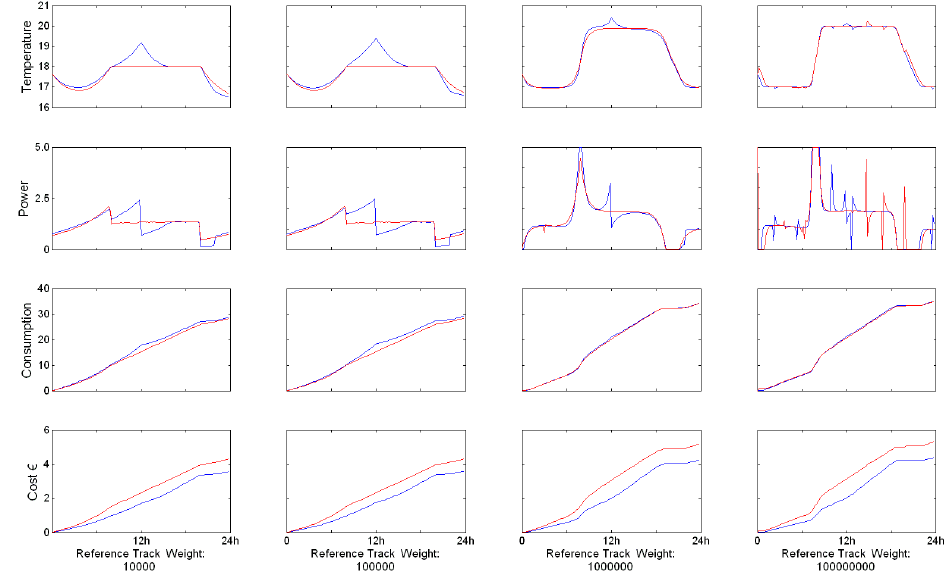
Figure 10. One ‐ day for a comparison between a Time of Use (TOU) tariffed (blue) and no time discriminative (red) Model Predictive Control (MPC) for different weight relations. Indoor temperature (°C), Power use pattern (kW), total consumption (kW ∙ h) and economic cost (€) are represented row wise.